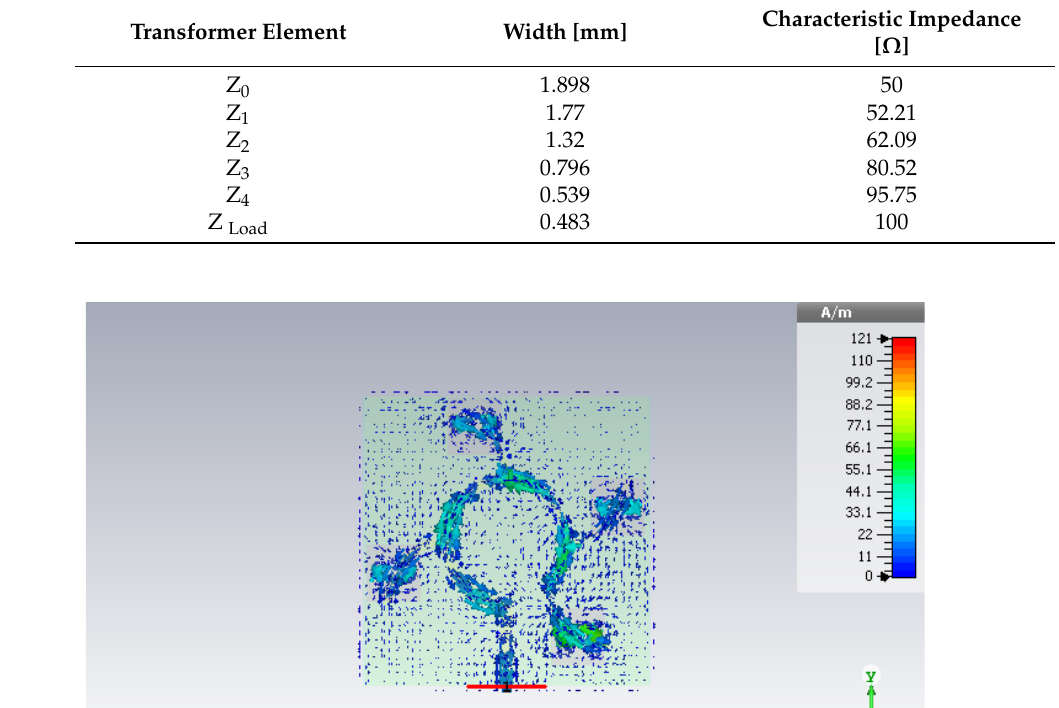
Table 1. Width and characteristic impedance of the transformers. Transformer Element